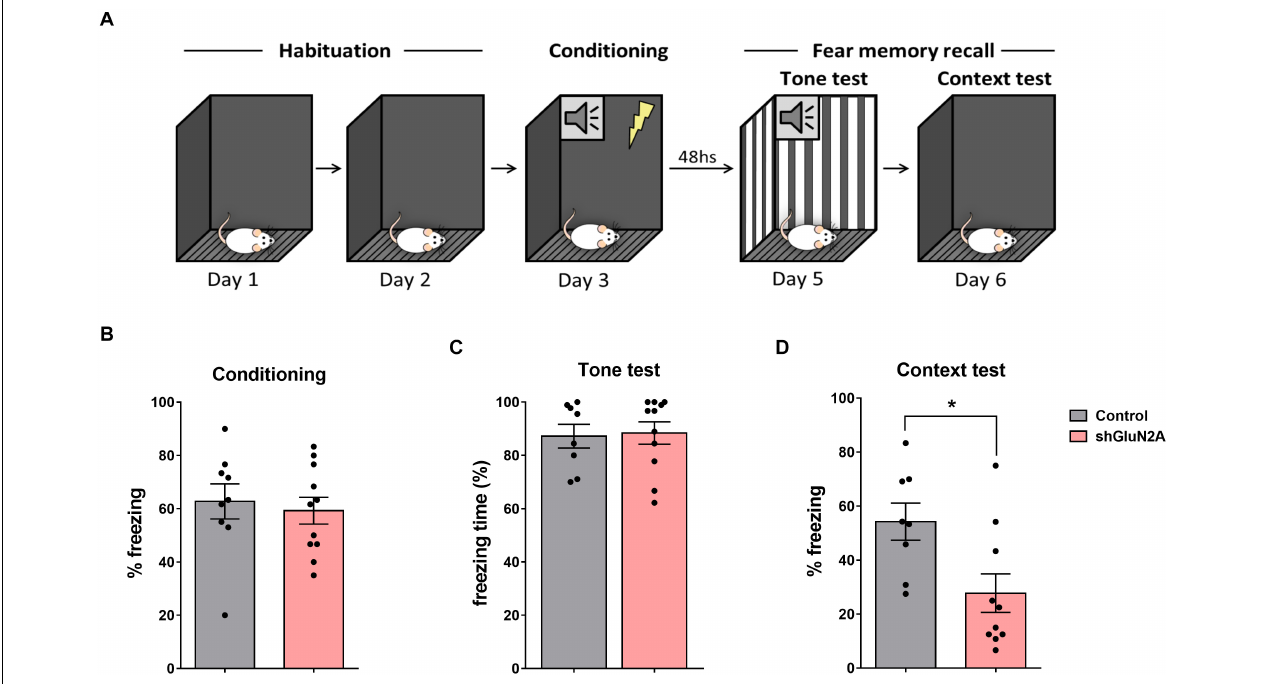
FIGURE 5 | Fear conditioning. (A) Representative scheme of the experimental design. Habituation to the context for 10 min on 2 consecutive days. Then, in the conditioning session, the tone (CS) was paired with 0.5-mA foot shock. Tone test: exposure to the tone in a novel context. Context test: exposure to the conditioning context. (B) shGluN2A-injected animals showed similar freezing behavior during the conditioning session compared to shsc-injected rats ( p = 0.6722, unpaired t test). (C) There was no difference in freezing behavior between control and shGLUN2A-injected animals in the tone test ( p = 0.8537, unpaired t test). (D) shGLUN2A-injected rats showed a significant decrease in freezing expression during the context test (* p < 0.05, unpaired t test). Data are represented as mean ± SEM. N = 9 shsc-injected, N = 11 shGLUN2A-injected